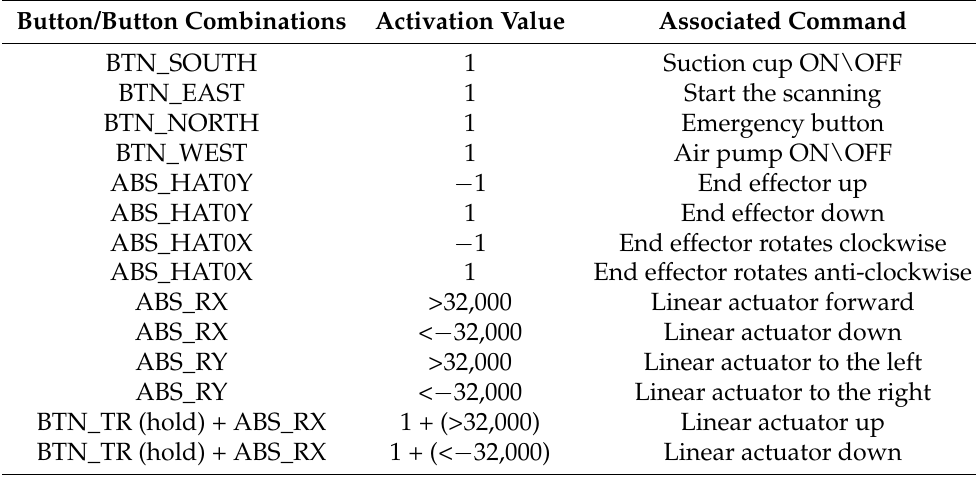
Figure 4. Gamepad. Table 2. Description of gamepad’s